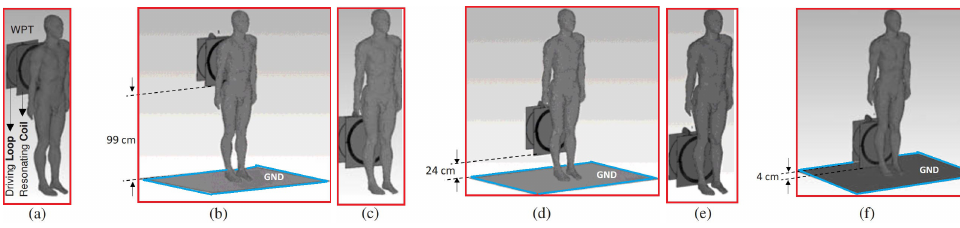
Figure 19. Tx part of a 10 MHz WPT system in proximity to a grounded and ungrounded Duke model at different locations with respect to the ground: ( a , c , e ) ungrounded, ( b , d , f ) grounded.